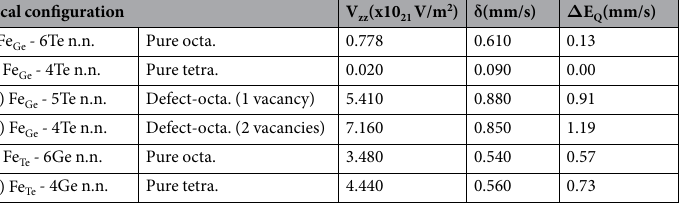
Table 2. DFT calculated electric field gradient ( V zz ) and Mössbauer parameters δ and ΔΕ Q for Fe at Ge and Te sites in GeTe, in the indicated symmetry structure. For Fe at the Ge site, the situation in which Te is replaced with 1 and 2 vacancies in c-GeTe is also